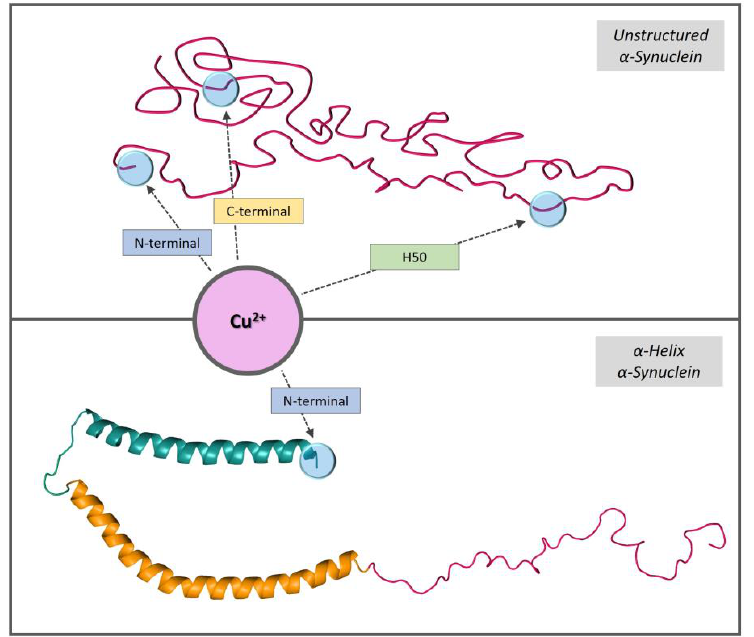
Figure 6. Schematic representations of α Syn copper(II)-binding sites in aqueous and membrane environments.